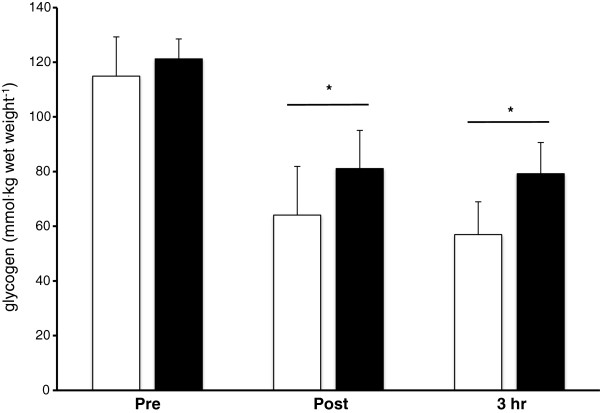
Muscle glycogen concentration pre, post-exercise and following 3 hr of recovery. Open and solid bars represent the P and CHO trials respectively. * - indicates a significant main effect of time.